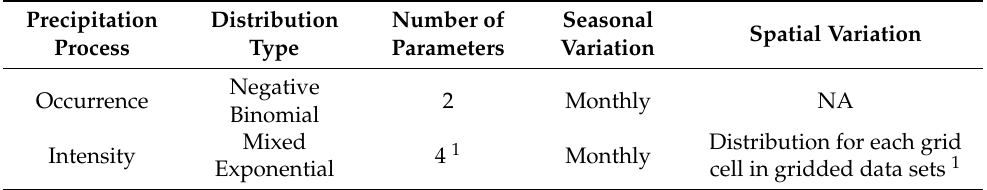
Table 1. Precipitation processes and probability